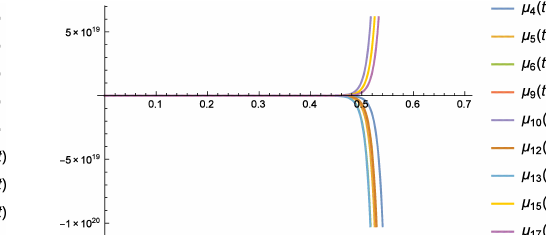
Fig. 7. The last phase of the state of the stock markets. There happens no resisting nor getting affected, the healthy and unhealthy states of the stock markets grow